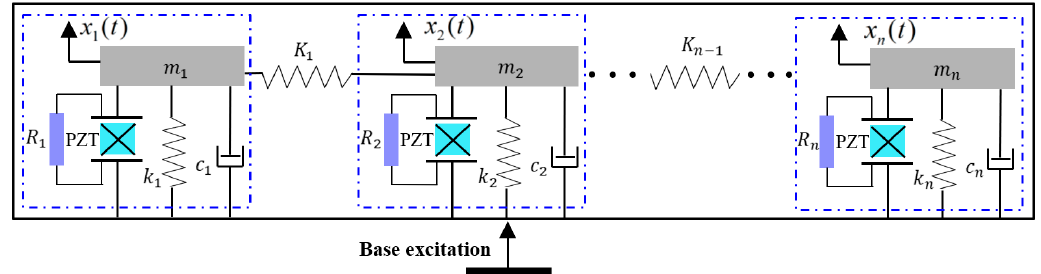
Figure 1. Schematic diagram of the NPEHS.